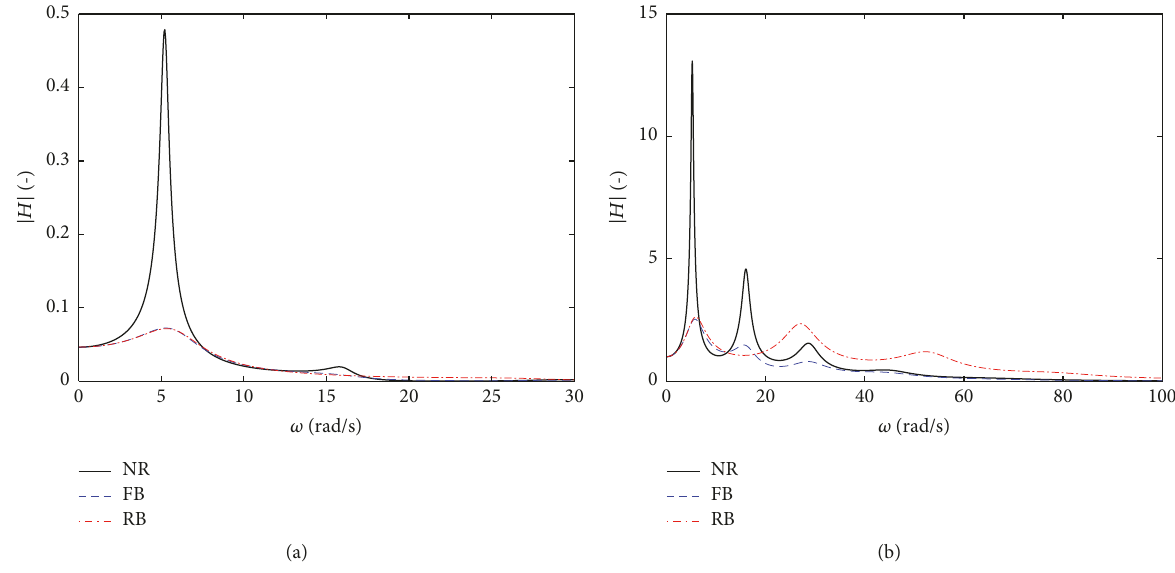
Figure 4: FRFs of the NR, FB, and RB systems in terms of (a) top floor displacement; (b) top floor acceleration.